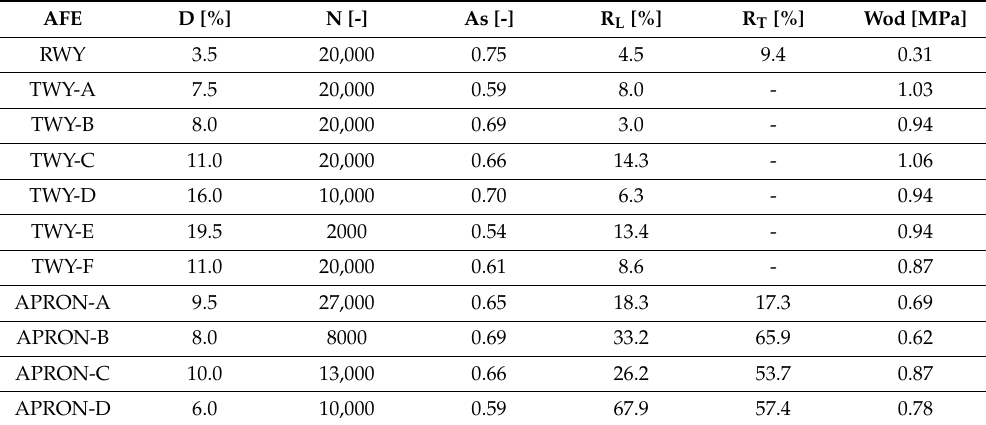
Table 3. Test results of individual input data parameters for analysis by the APCI